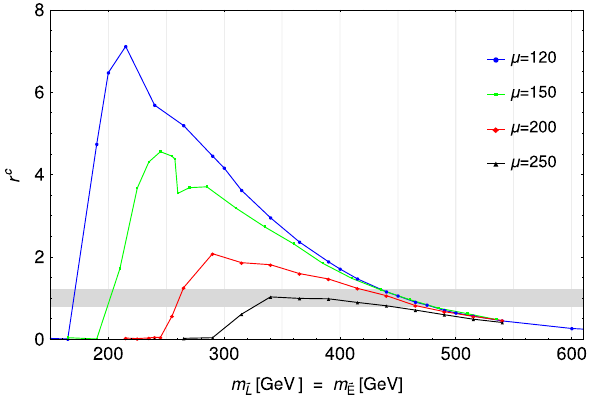
and μ due to chargino pair R . Color conventions follow R